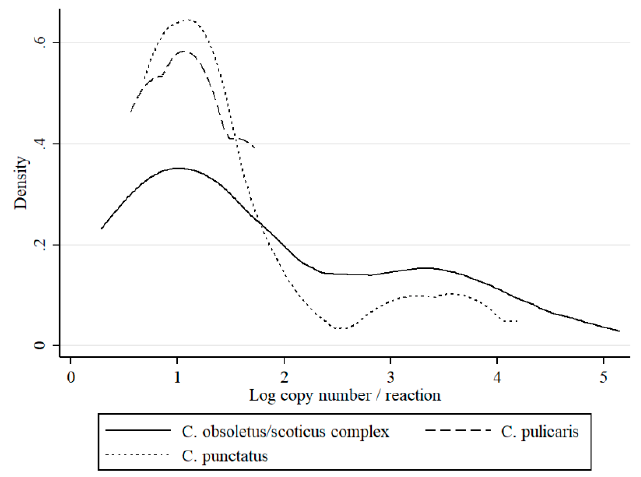
Figure 2. Distribution of estimated RNA copy numbers per sample (logarithm) values of optimized real-time reverse transcriptase-polymerase chain reaction (QRT-PCR) for Schmallenberg virus (SBV) detection by kernel density plot in respect to Culicoides